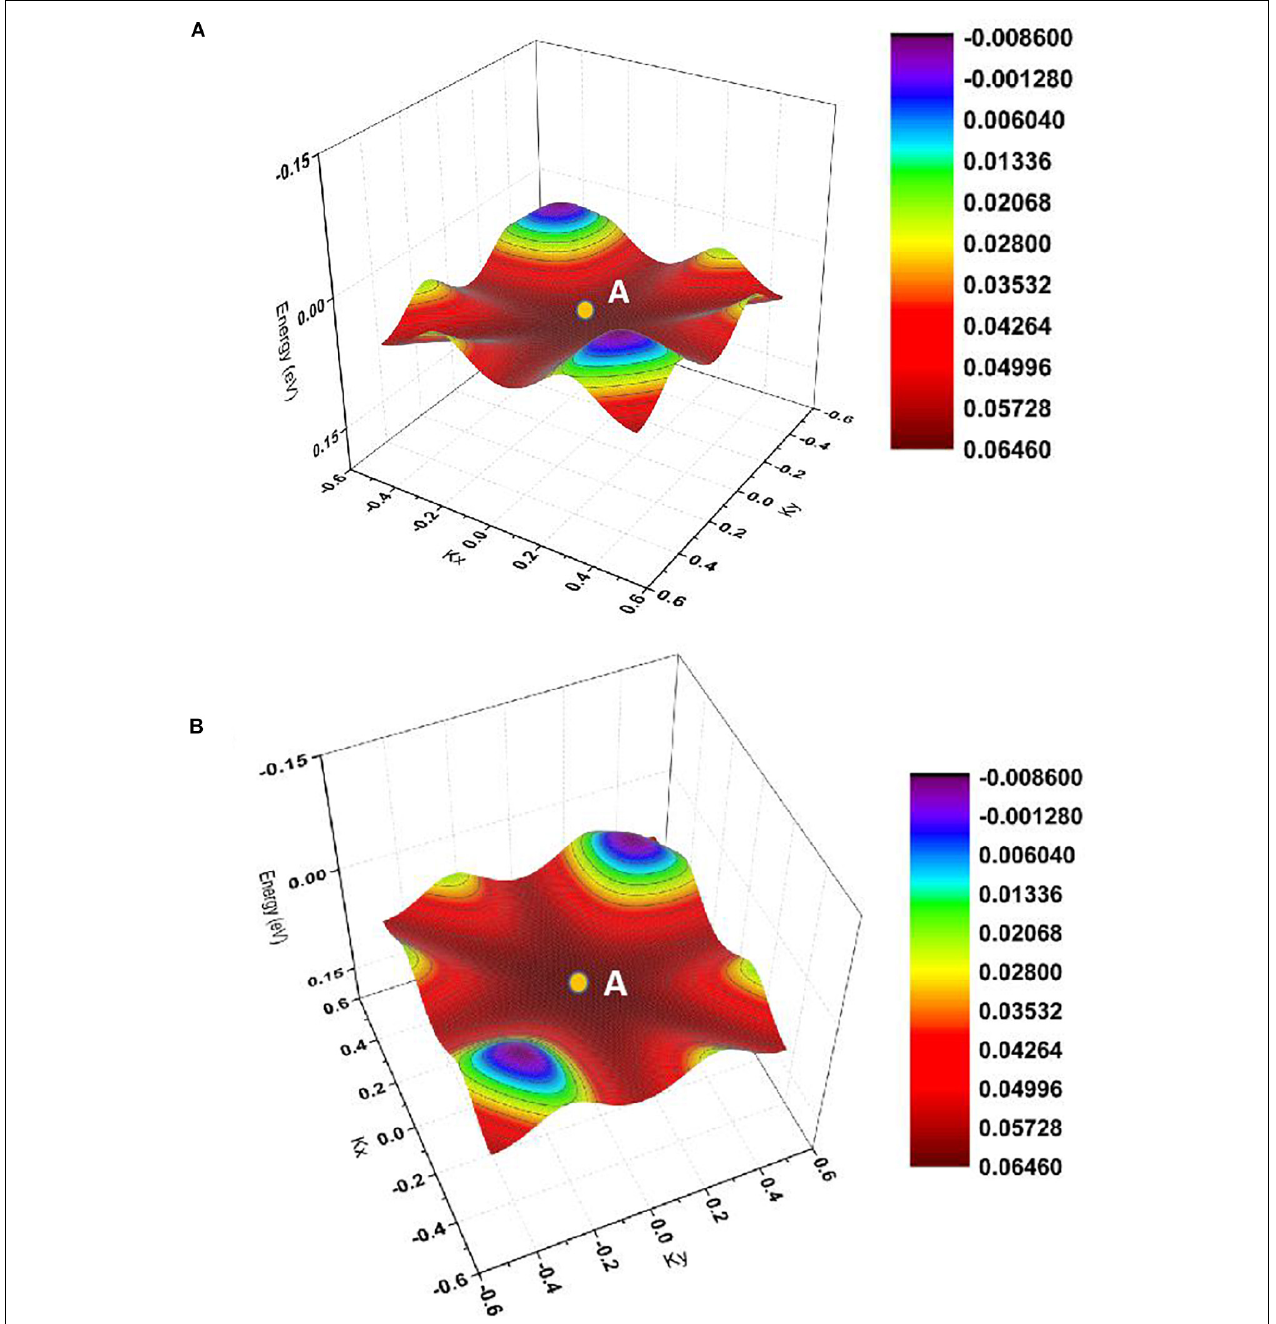
FIGURE 7 | A-point centered 3D band structures of CsCrCl 3 ferromagnet at k z = π plane in spin-up channel (without SOC effect). (A,B) are from different view